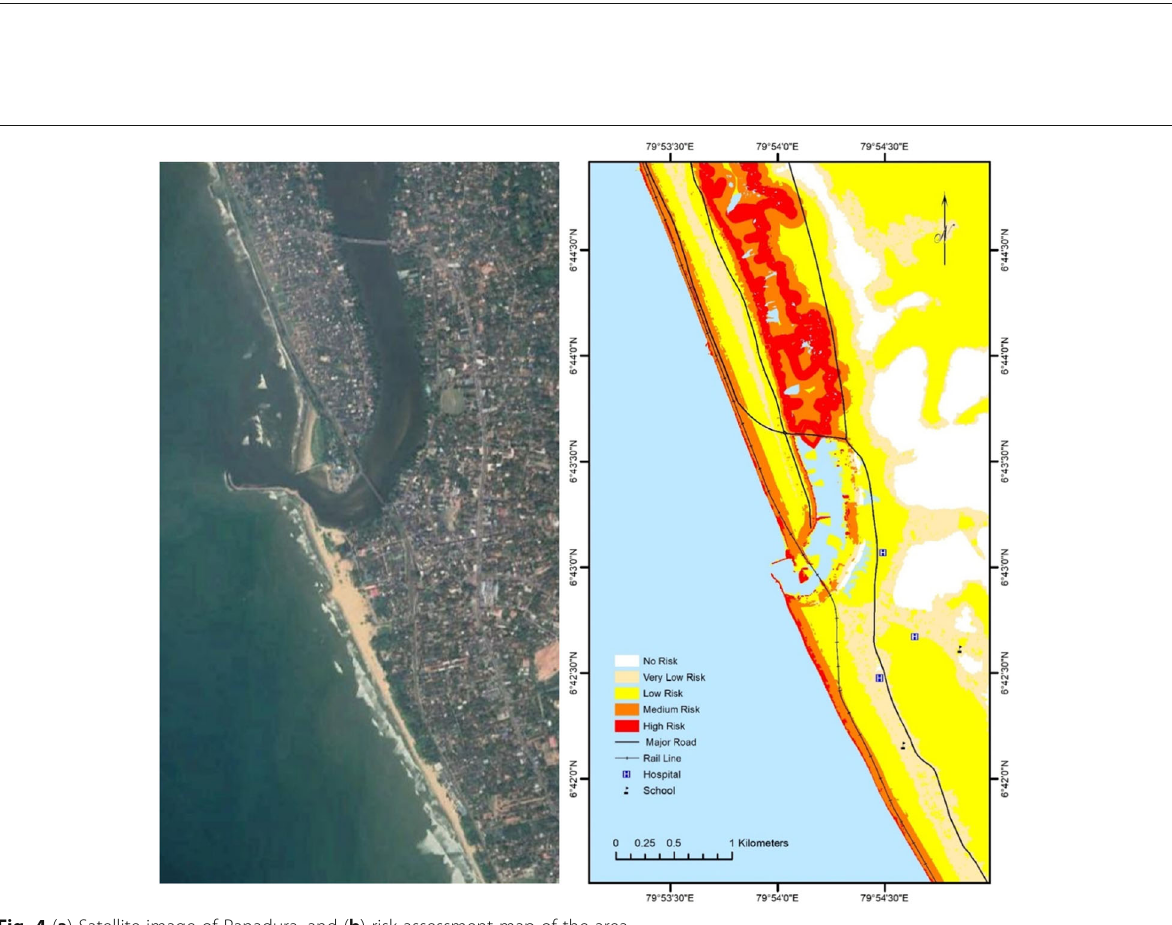
Fig. 3 Graph illustrating corrected data for seasonal component (solid lines), and the linear trend line (dotted lines) for the Hulhule and Gan tidal stations in the Maldives, and Colombo tidal station in Sri Lanka. (See appendix for original time series data and deseasonalized data)